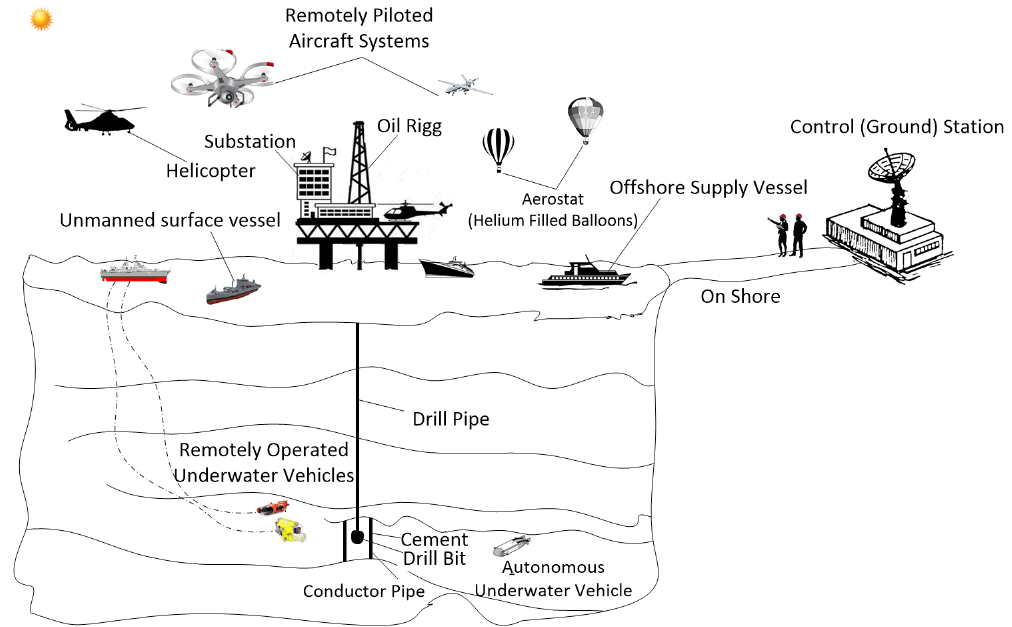
Figure 10. Application of EC in Oil and Gas